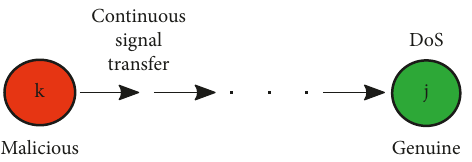
Figure 3: Jamming attack at the physical